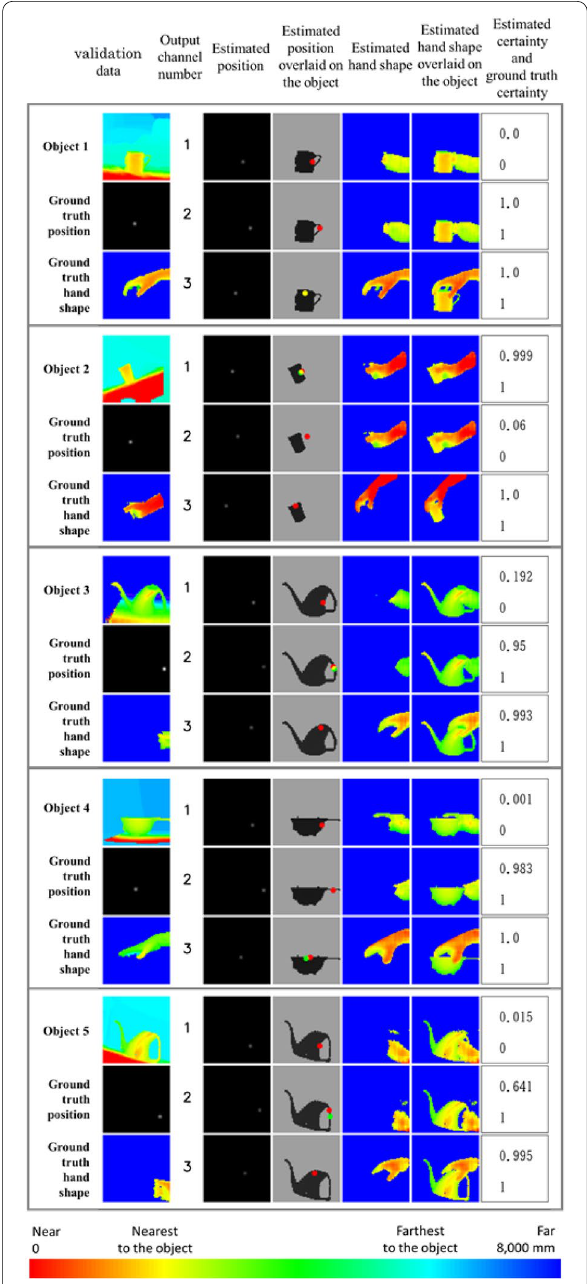
Fig. 12 Results of recalling the grasping methods with certainty for the validation data